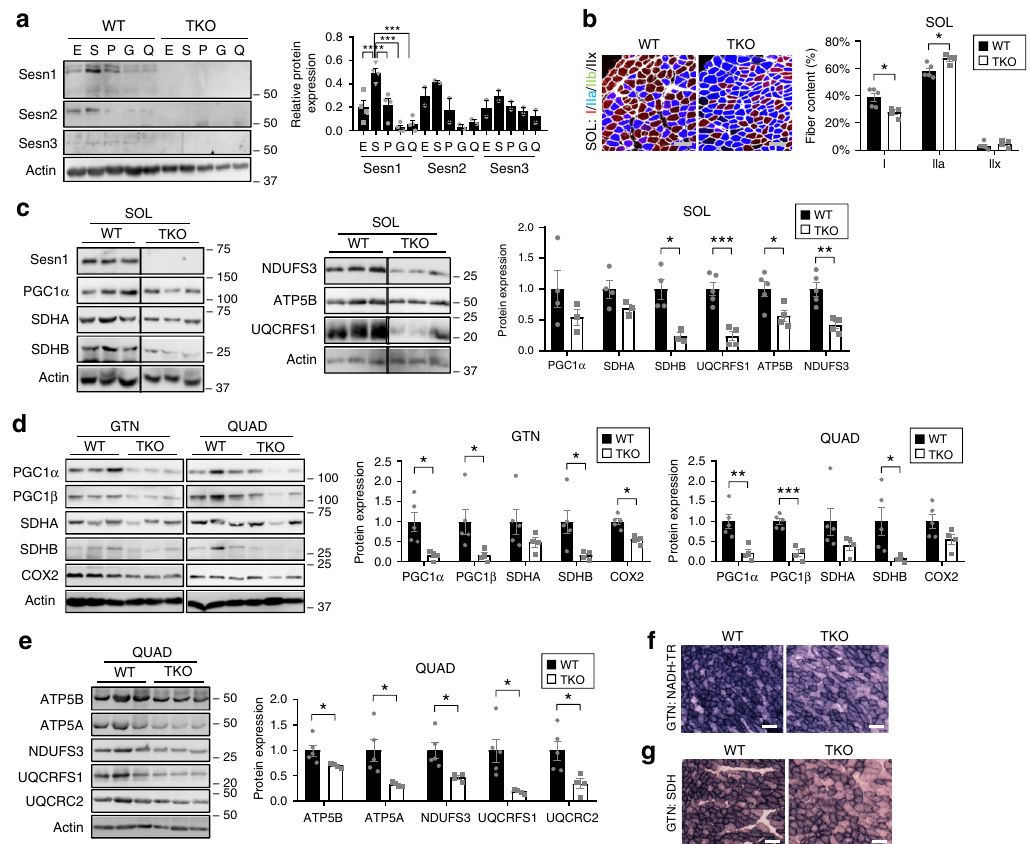
Fig. 5 Sestrin regulates mitochondrial biogenesis in skeletal muscle. a Sestrin expression in different muscle tissue was analyzed by immunoblotting and band densitometry. E, extensor digitorum longus; S, soleus (SOL); P, plantaris; G, gastrocnemius (GTN); Q, quadriceps (QUAD). b Soleus muscle was analyzed by immunostaining visualizing extracellular matrix (white) and myo fi bers of type I (red), IIA (blue), IIB (green; SOL did not contain IIB fi bers in our analysis) and IIX (black). Fiber contents of the whole cross-section were quanti fi ed (right). c – e Indicated muscle tissues were analyzed by immunoblotting and band densitometry. f , g Mitochondrial complex I (NADH-TR) and II (SDH) activities were visualized from fresh frozen sections of indicated mouse muscle. Scale bars, 100 µ m. Biologically independent animals: n = 4, 2, 2 ( a ; Sesn1, Sesn2 and Sesn3 analyses, respectively), n = 5, 4 ( b , d , e ; WT and TKO, respectively), n = 4, 3 ( c , PGC1 α , SDHA and SDHB; WT and TKO, respectively), n = 5, 4 ( c , all other proteins; WT and TKO, respectively). Error bars, s.e.m. * P < 0.05, ** P < 0.01 or *** P < 0.001 from a two-tailed student ’ s t test. Molecular weight markers are indicated in